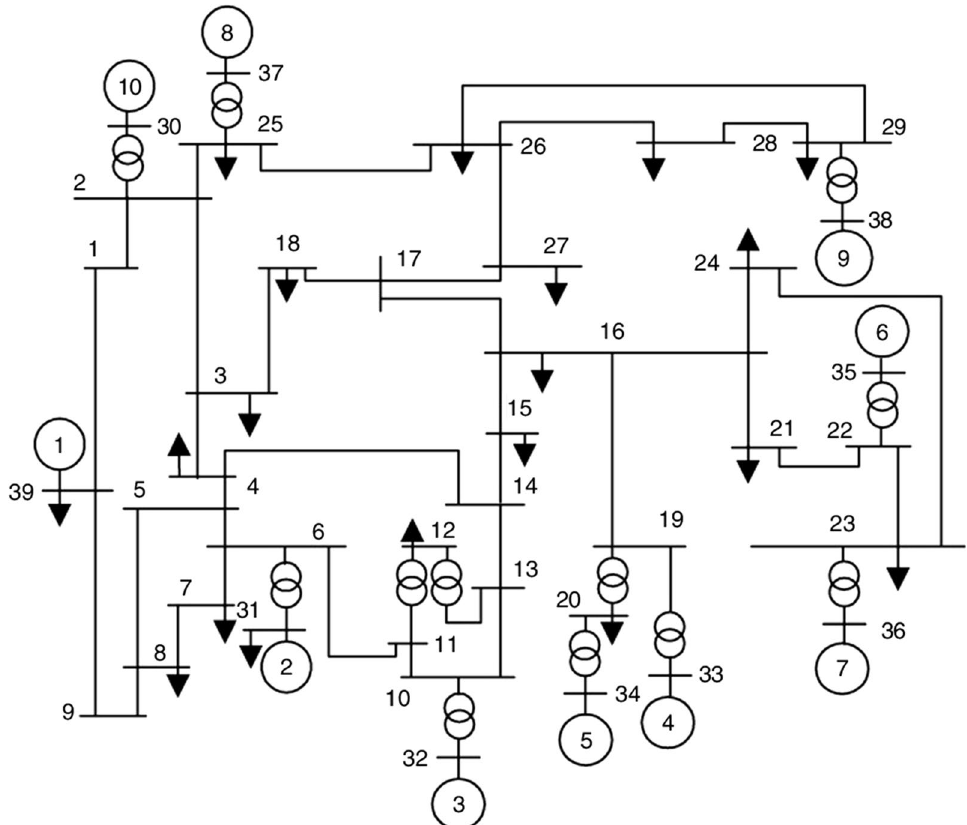
Fig. 3 Block diagram of the New England 10-generator 39-bus